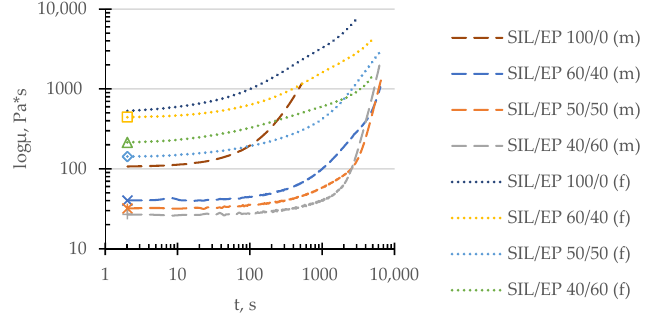
Figure 3. Viscosity growth in time of compatibilized model (m) and completed (f) systems, follow- ing SIL/EP wt.-to-wt. ratios: 100/0 (…/---), 60/40 ( □ /x), 50/50 ( ∆ /  ) and 40/60 ( ◊ /+).